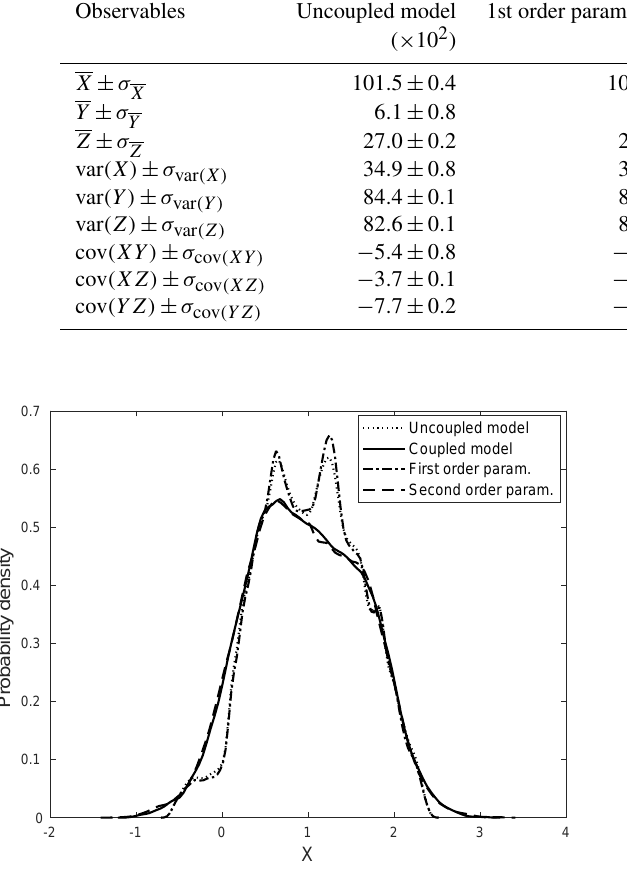
Figure 4. Probability density of the X variable. For case τ = 5, the Lorenz 63 model acts as a fast forcing on the Lorenz 84 model.